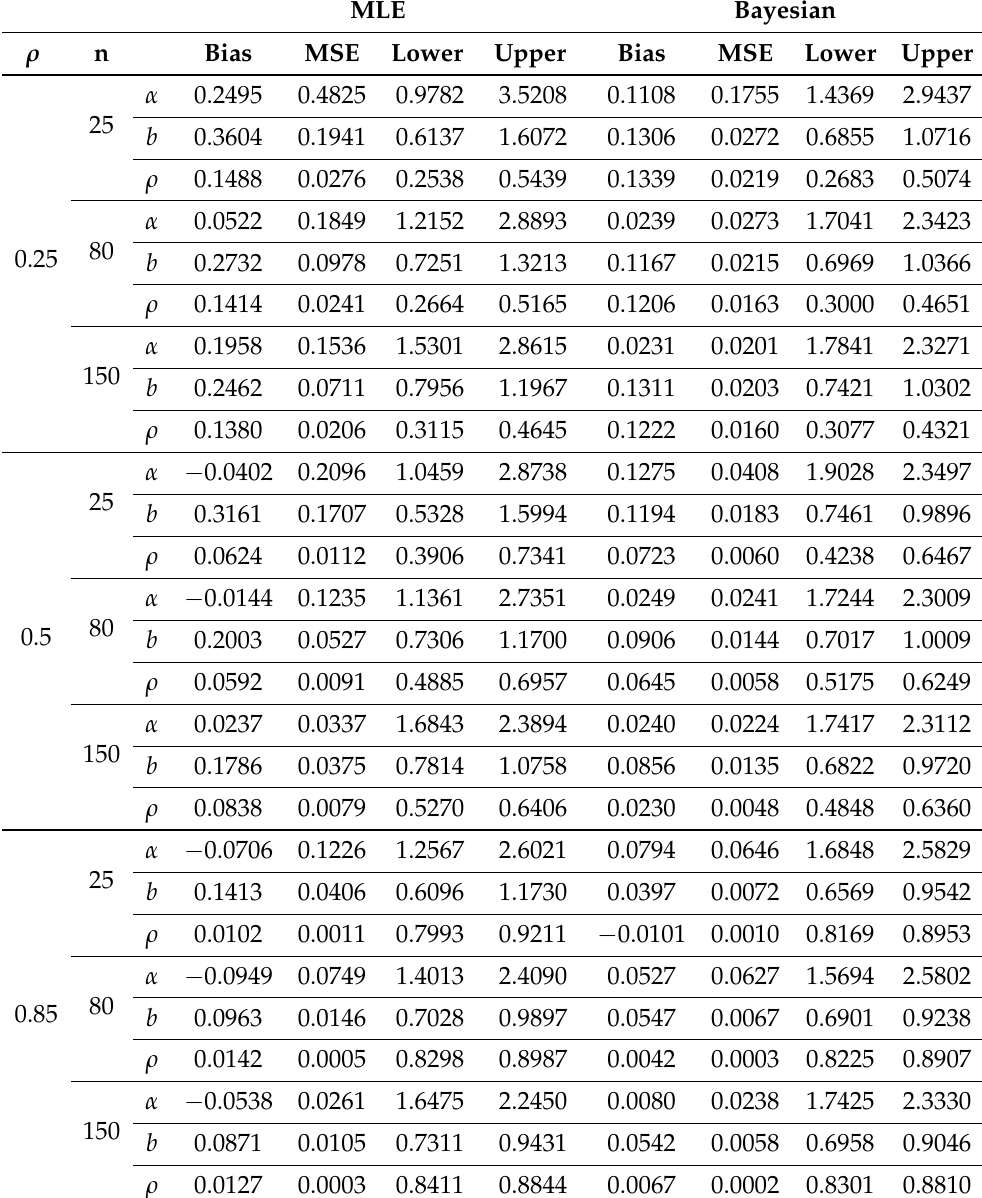
Table 2. Bias, MSE, Lower, and Upper of CIs for parameters of WMOE distribution: Case 1